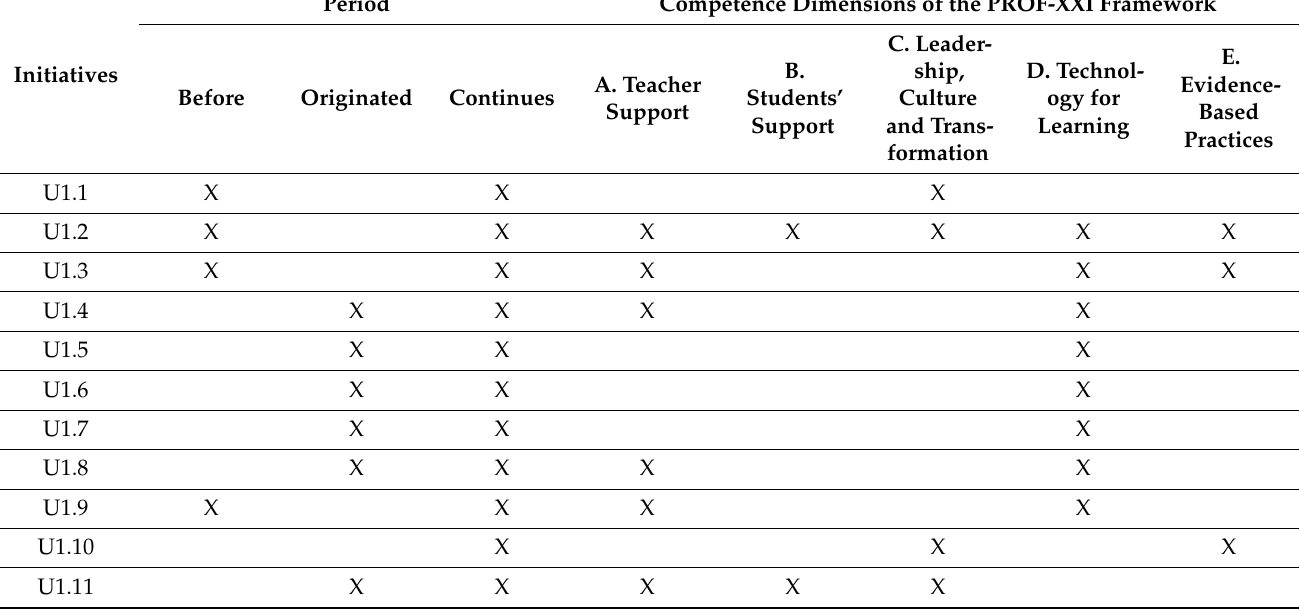
Table A7. Original list of initiatives collected through the [Pre&Post Pandemic Lockdown Forms] translated to English. Columns of section “Periods”: Before, the initiative existed before the pandemic lockdown; Originated, the initiative was originated during the pandemic lockdown; Continues, the initiative is maintained at the institution after the pandemic lockdown. We indicated under study those initiatives that the university is still studying whether to be maintained or